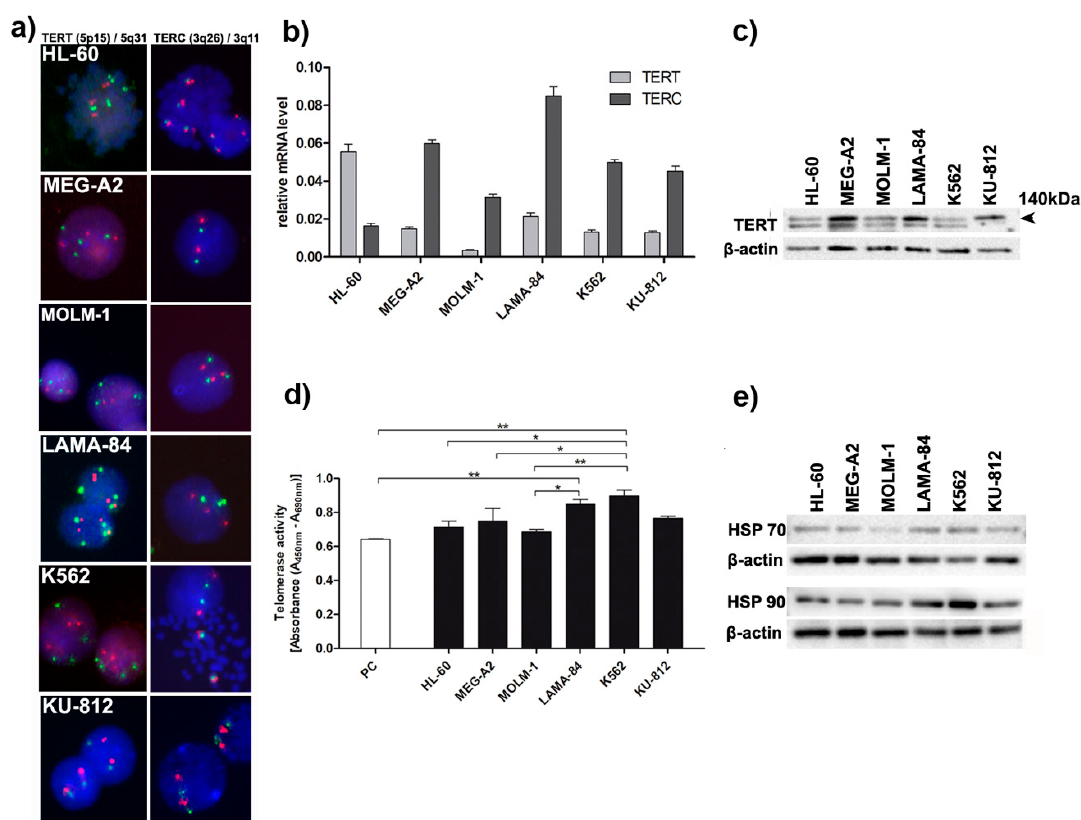
Figure 3. Telomere length is associated with enzymatic activity of telomerase and with expression/gene copy number of TERT/TERC in BCR/ABL1 -positive cell lines. ( a ) Representative images of nuclei and/or metaphase plates with TERT/TERC probe. Nuclei were counterstained by DAPI. Fluorescent signals were visualized under the Olympus BX61 and MetaSystem Isis software with objective 40×; ( b ) RT-qPCR analysis of TERT/TERC normalized to β 2M and GUSB expression; ( c ) Western blot analysis of TERT protein levels. For the loading control, the antibody against β -actin was used; ( d ) PCR-ELISA measurement of telomerase activity. The bars indicate SD, n = 2, * p < 0.05, ** p < 0.01 (ANOVA and Tukey’s a posteriori test); ( e ) Western blotting analysis of HSP70 and HSP90. For the loading control, β -actin was used.